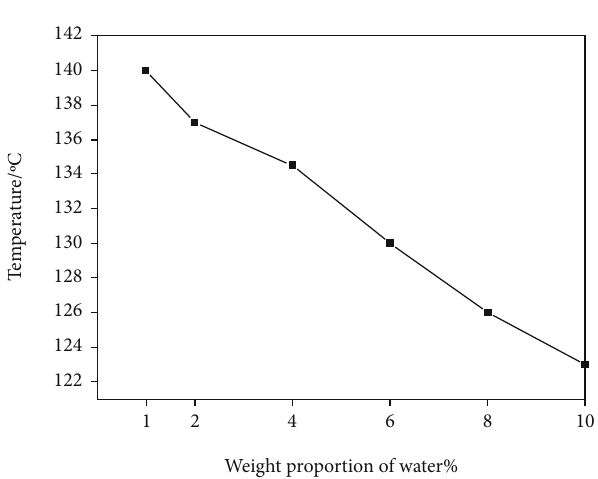
Figure 6: In fl uence of the weight proportion of HCFC-141b on the curing temperature threshold.